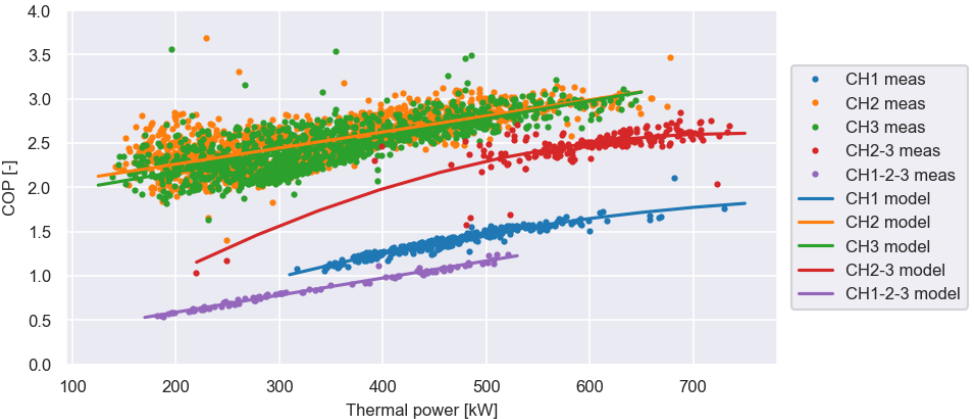
Figure 6. Chilled water system data-driven performance curves obtained with operational data. The electric power accounts for the chiller(s) in operation and the associated auxiliary equipment (i.e., circulation pumps, cooling tower fans, air-cooled condenser